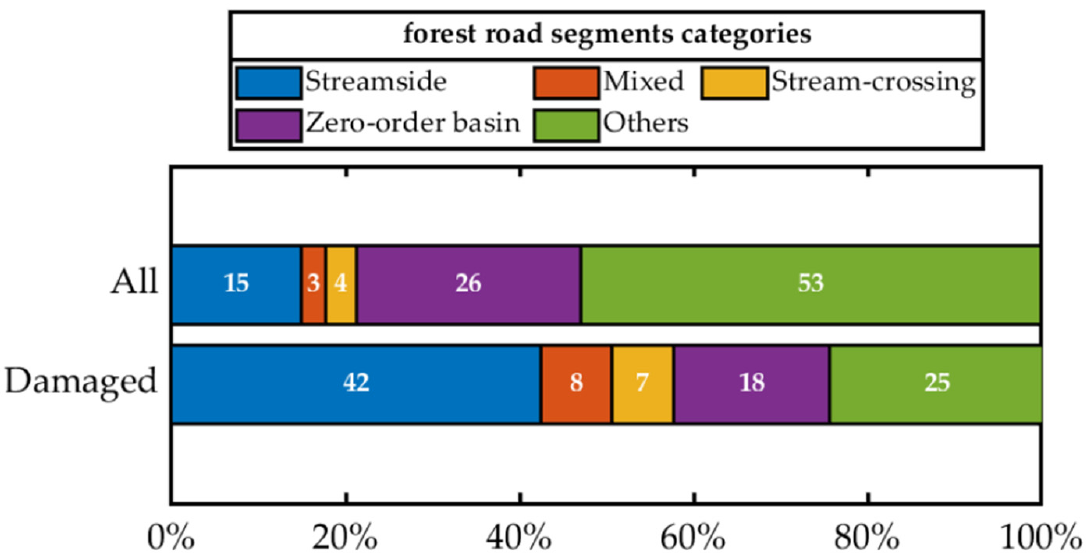
Figure 8. Percentage of all forest road segments and damaged forest road segments by terrain type category.” Mixed” indicates segments that fall into both streamside and zero-order basin landforms.